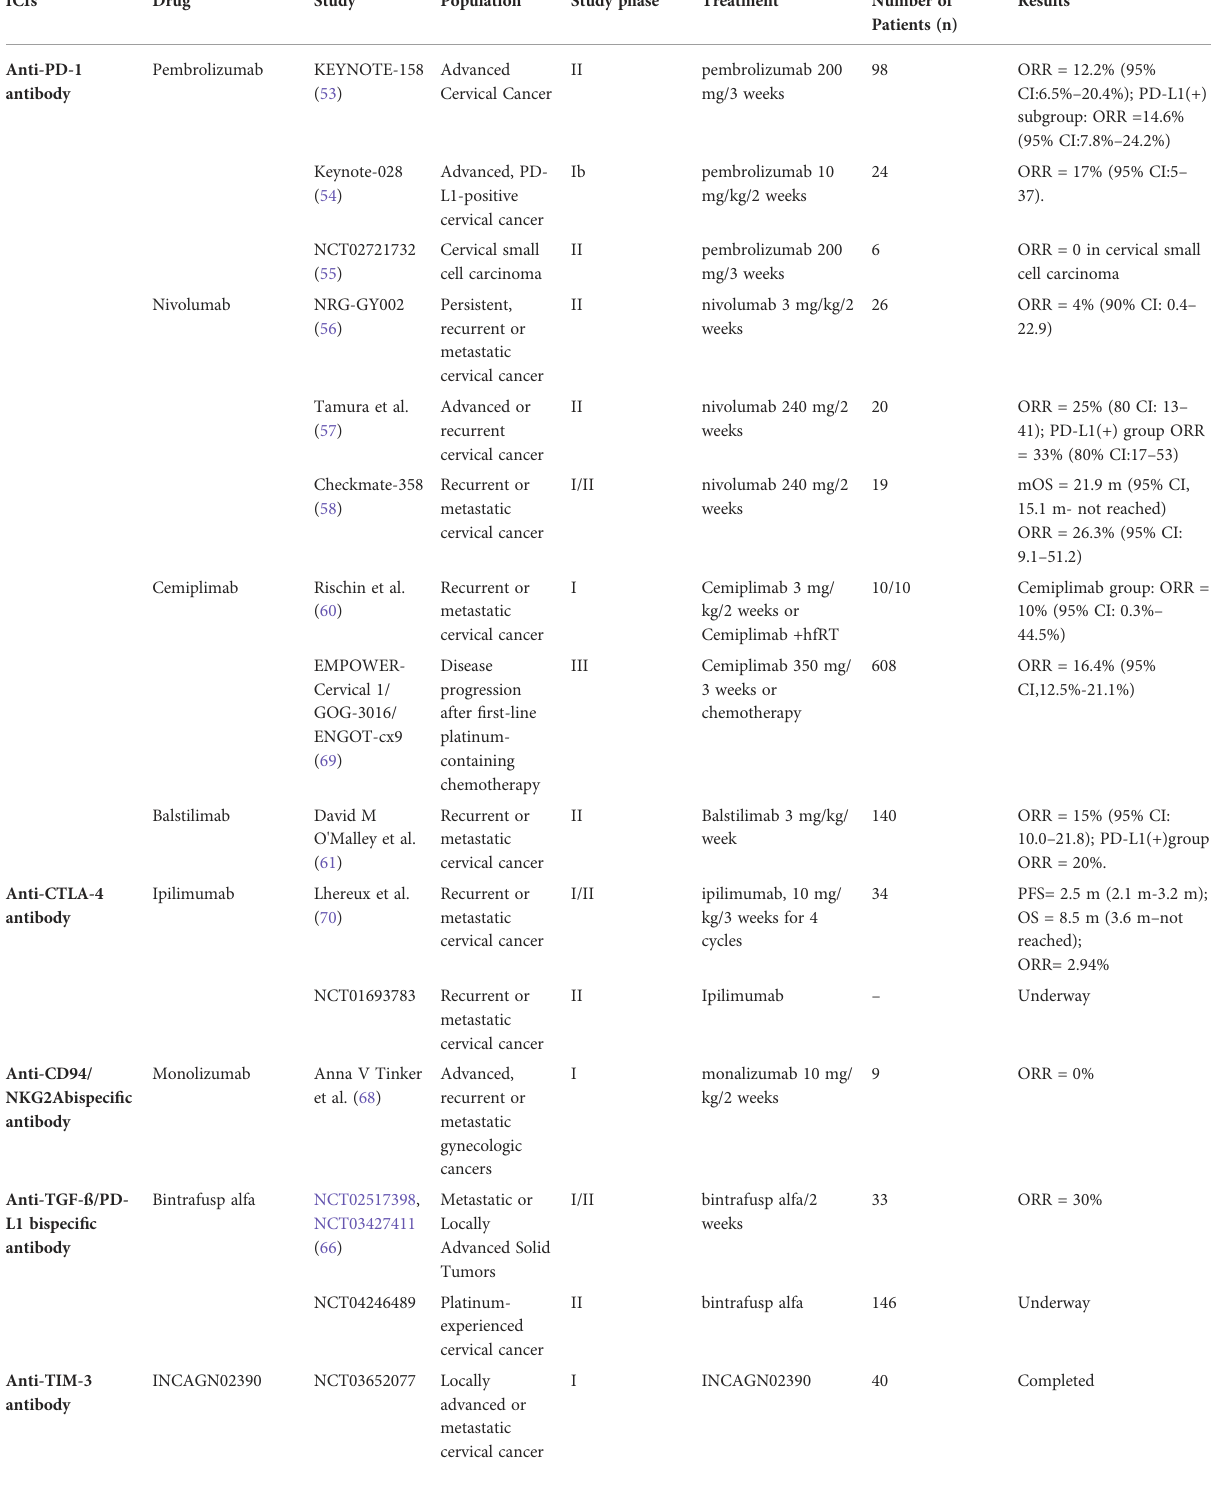
TABLE 1 Trials of ICI single-agent therapy in advanced cervical